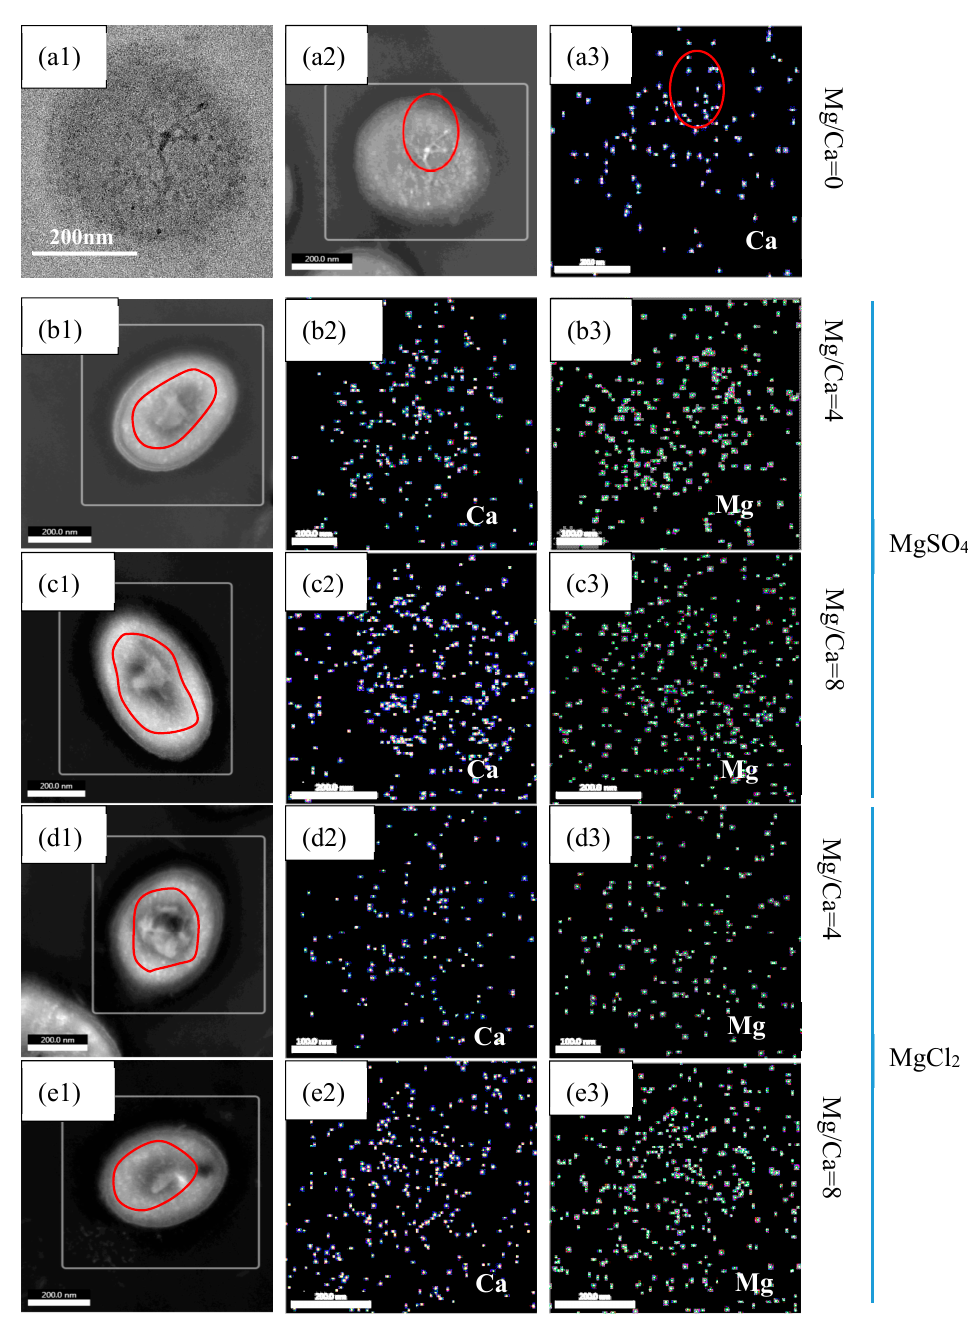
Figure 10. STEM and EDS analyses of the ultrathin slices of S. epidermidis Y2. The intracellular light area marked by a red circle is the research target. ( a1 ) TEM of S. epidermidis Y2; ( a2 ) STEM at Mg/Ca ratio of 0; ( a3 ) EDS of Ca at Mg/Ca ratio of 0; ( b1 ) STEM of S. epidermidis Y2 at Mg/Ca ratio of 4 in the MgSO 4 medium; ( b2 , b3 ) EDS of Ca and Mg at Mg/Ca ratio of 4 in the MgSO 4 medium, respectively; ( c1 ) STEM of S. epidermidis Y2 at Mg/Ca ratio of 8 in the MgSO 4 medium; ( c2 , c3 ) EDS of Ca and Mg at Mg/Ca ratio of 8 in the MgSO 4 medium, respectively; ( d1 ) STEM of S. epidermidis Y2 at Mg/Ca ratio of 4 in the MgCl 2 medium; ( d2 , d3 ) EDS of Ca and Mg at Mg/Ca ratio of 4 in the MgCl 2 medium, respectively; ( e1 ) STEM of S. epidermidis Y2 at Mg/Ca ratio of 8 in the MgCl 2 medium; ( e2 , e3 ) EDS of Ca and Mg at Mg/Ca ratio of 8 in the MgCl 2 medium, respectively.